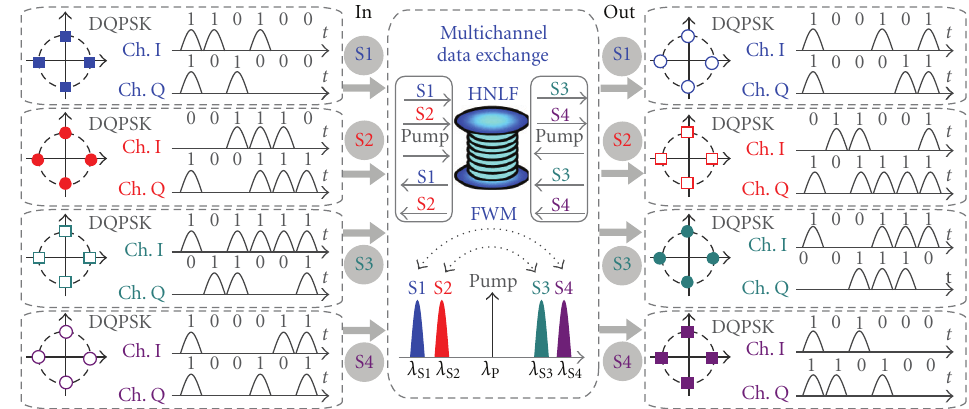
Figure 20: Concept and principle of simultaneous multichannel DQPSK data